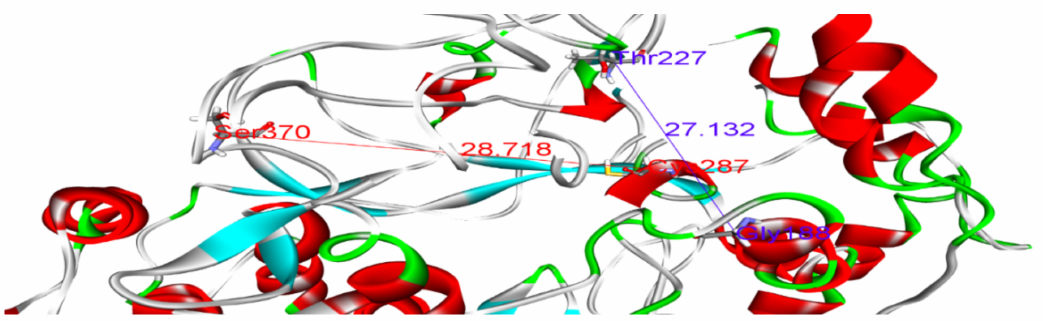
Figure 5. Distances between Gly188 and Thr227 (blue), and between Cys287 and Ser370 (dark red), in the sample 5